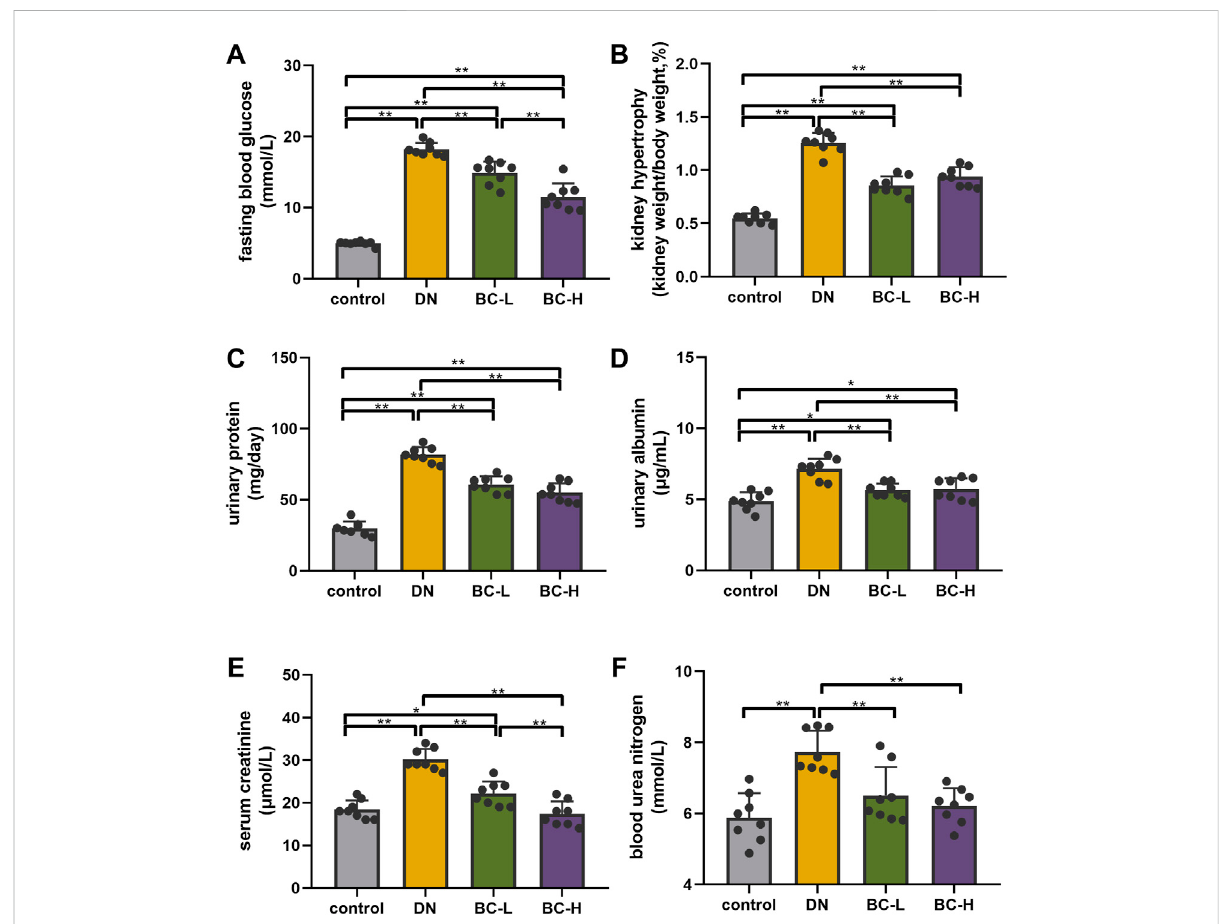
FIGURE 3 Bailing Capsule improved blood glucose and kidney function. (A) Bailing Capsule signi fi cantly reduced fasting blood glucose (FBG). (B) Bailing Capsule signi fi cantly reduced kidney hypertrophy. (C) Bailing Capsule signi fi cantly reduced 24 h urinary protein. (D) Bailing Capsule signi fi cantly reduced